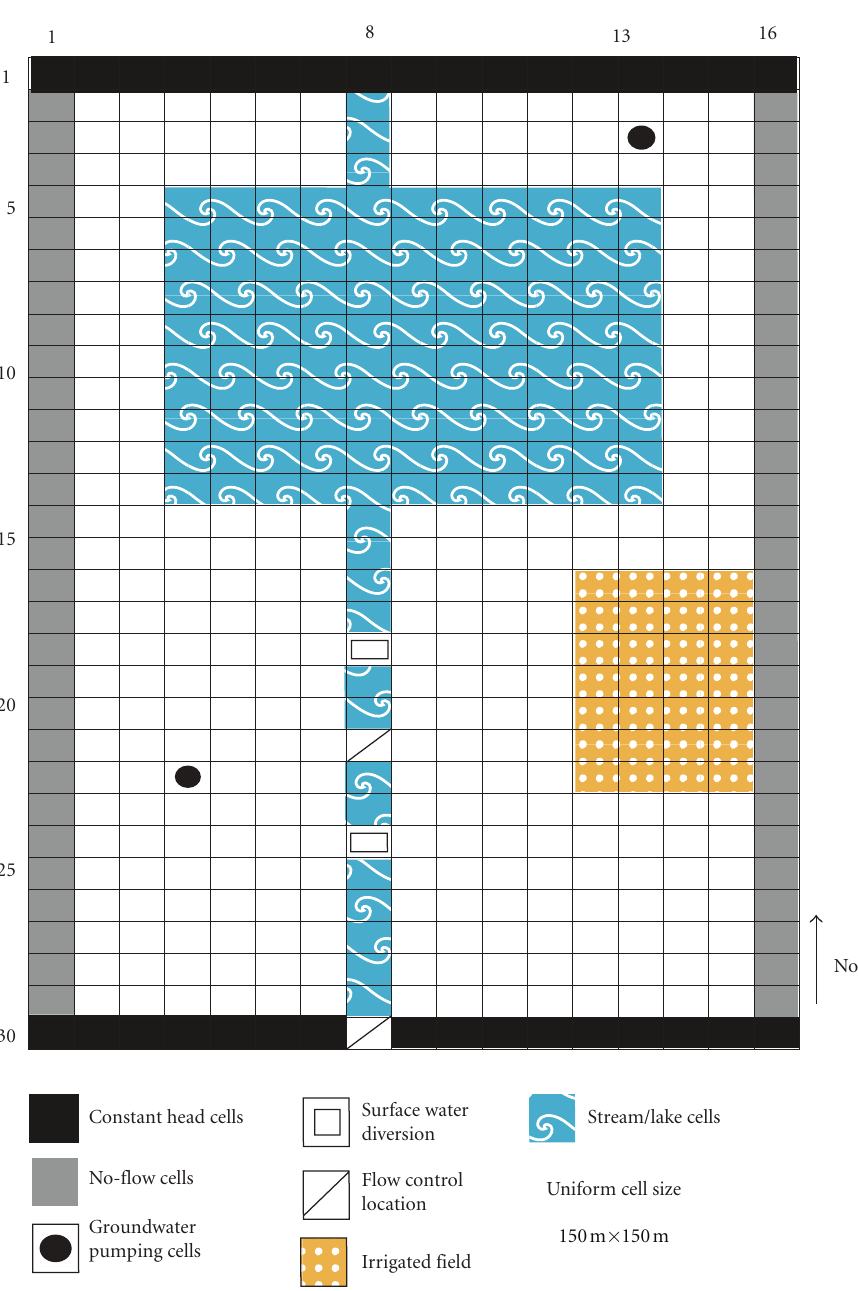
Figure 2: Discretization and cell types of the hypothetical study area.